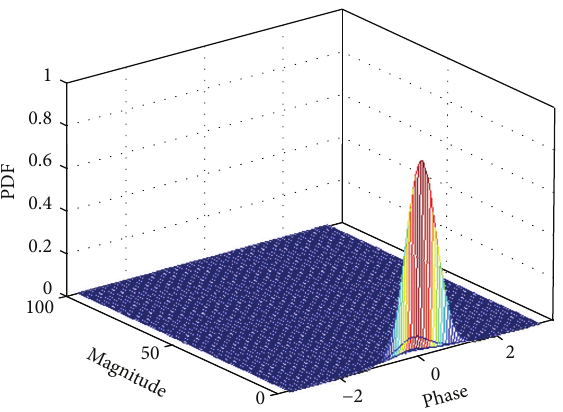
Figure 5: The estimated PDF of the previous area.